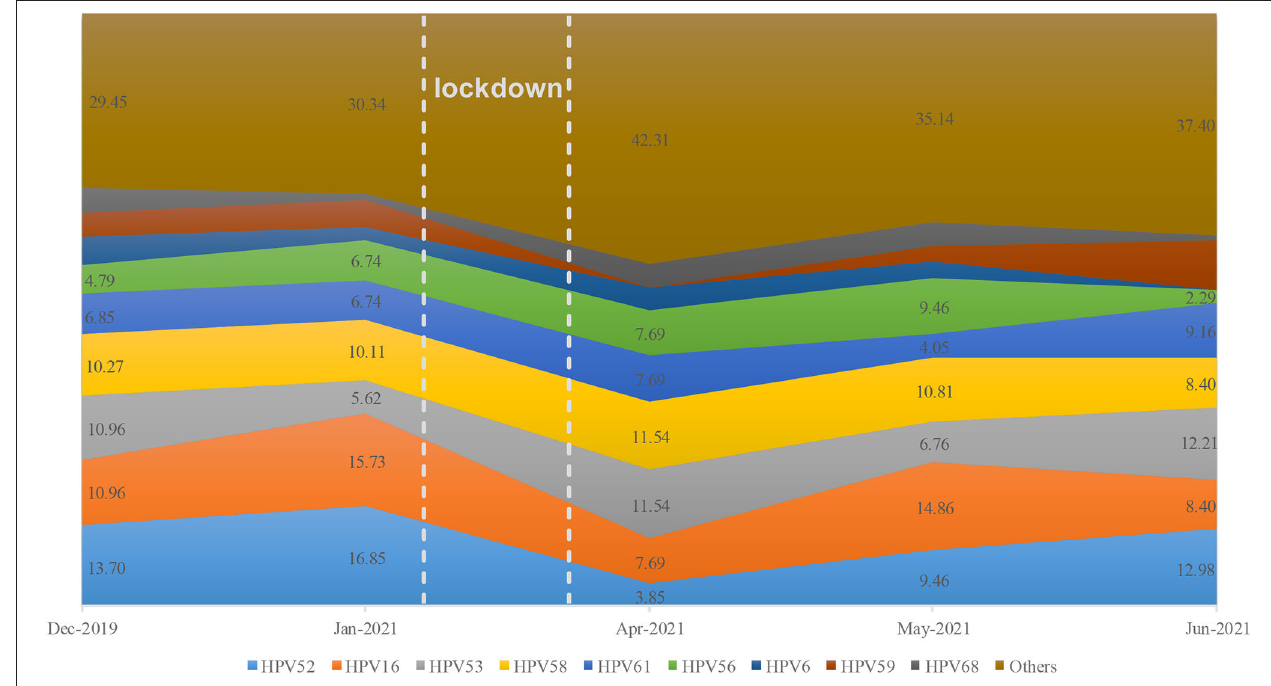
FIGURE 5 | Monthly distribution of HPV genotypes during the SARS-CoV-2